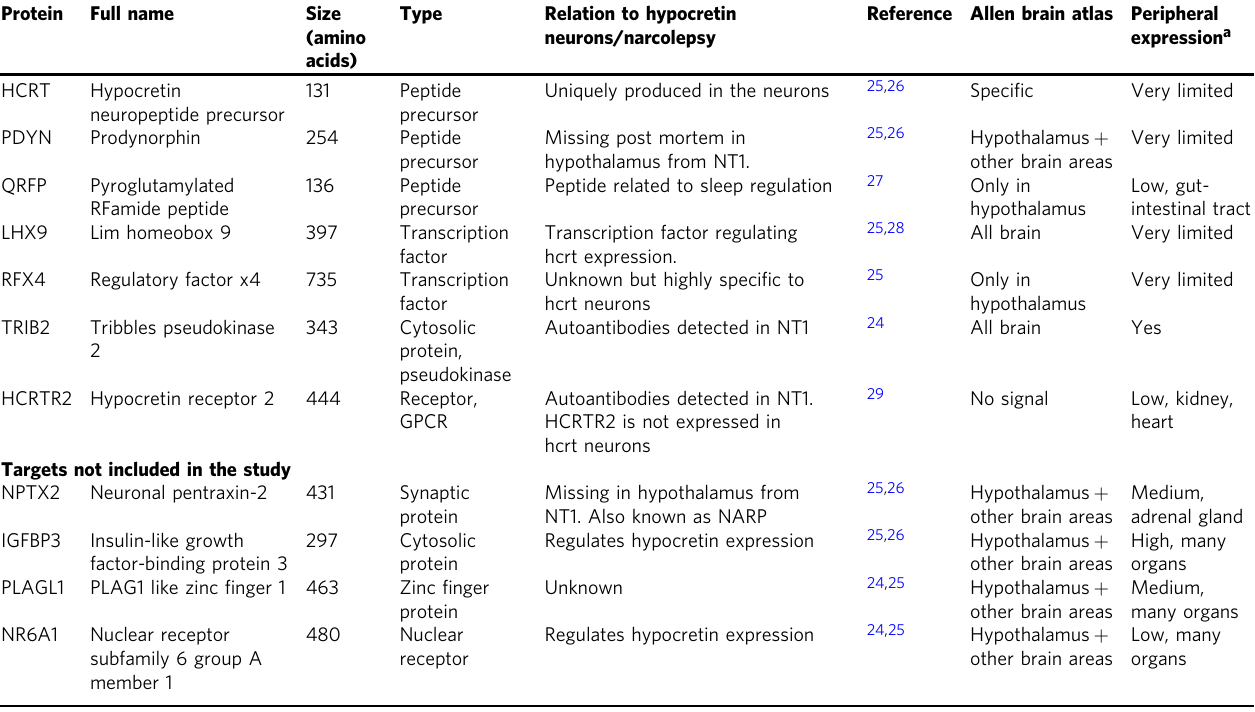
Table 2 Overview of the protein targets included in the study and potential targets of interest Targets included in the study